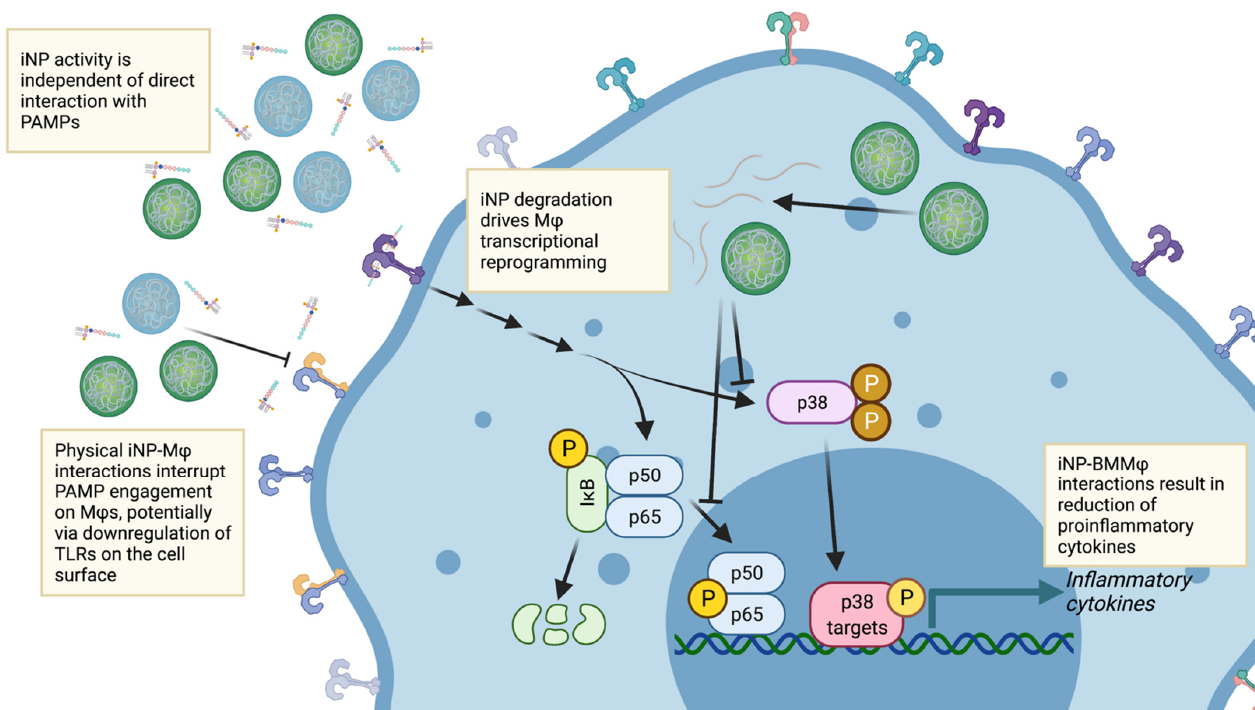
Figure 8. iNPs invoke multiple physical and biological mechanisms to elicit a protective effect in BMM Φ s. iNPs interact with BMM Φ s to interrupt the engagement of PAMPs on TLRs at both the cell surface and endosomal surface, thus limiting the activation of TLR signaling networks. However, if LPS engages TLR4, the iNPs function via a secondary mechanism whereby their degradation triggers BMM Φ transcriptional reprogramming in response to LPS. This reduces the overall activation and production of inflammation mediators resulting in an overall protective effect to PAMP challenge. Schematic created with BioRender.